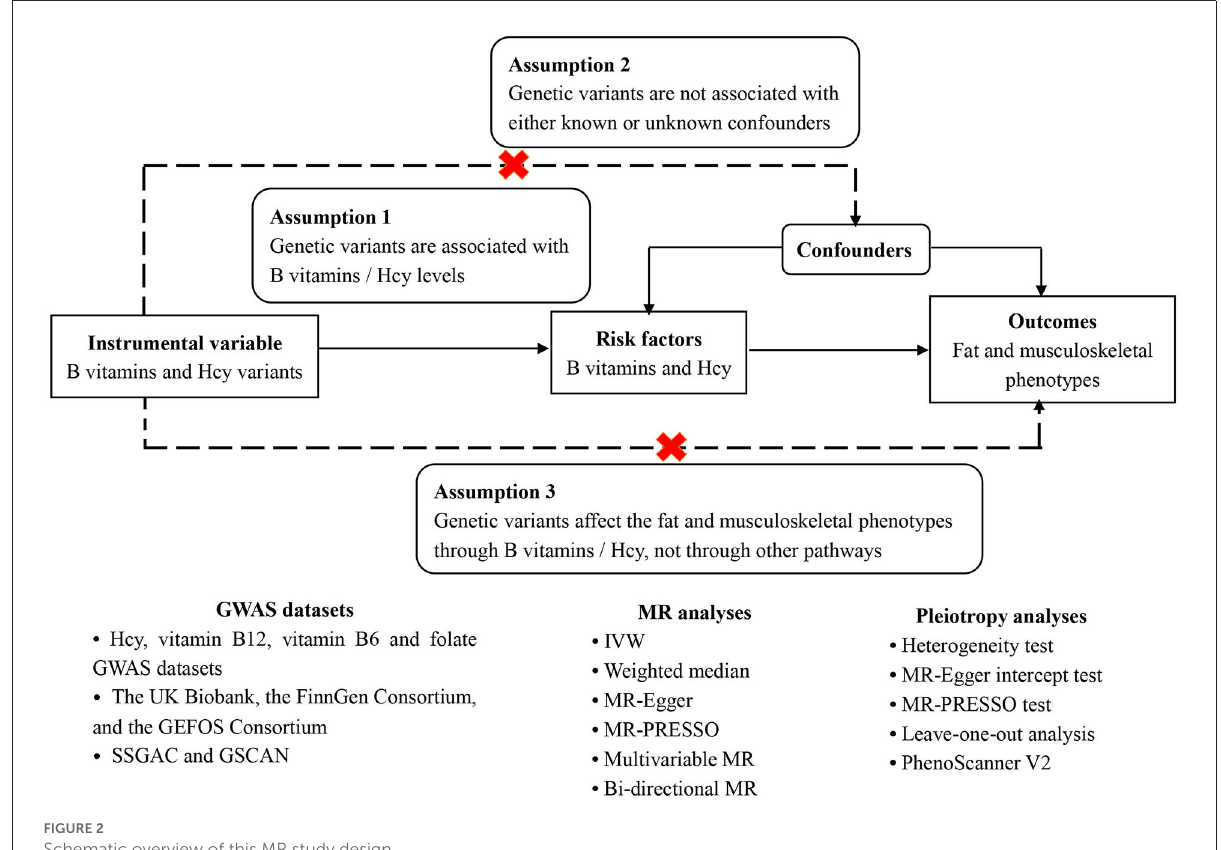
FIGURE2 Schematic overview of this MR study design.